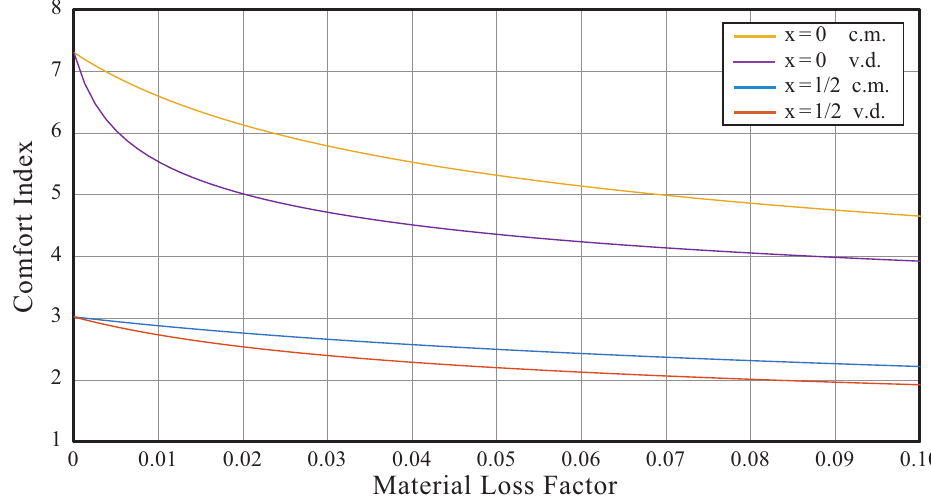
Figure 3. Comfort index at two locations on the beam versus the material loss factor ( η ) using both the viscous (v.d.) and complex modulus (c.m.) damping